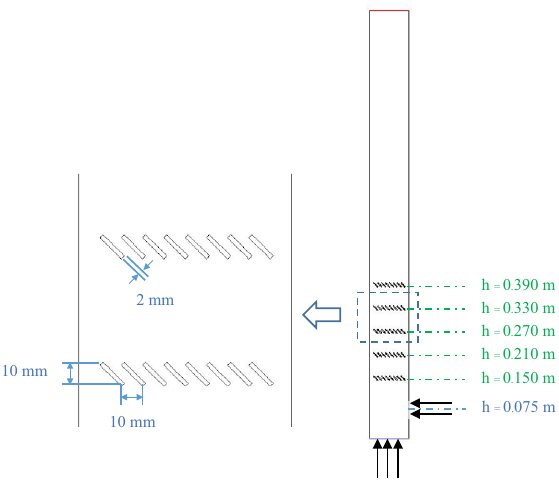
Figure 2. Configuration of the bubbling bed gasifier installed with louver